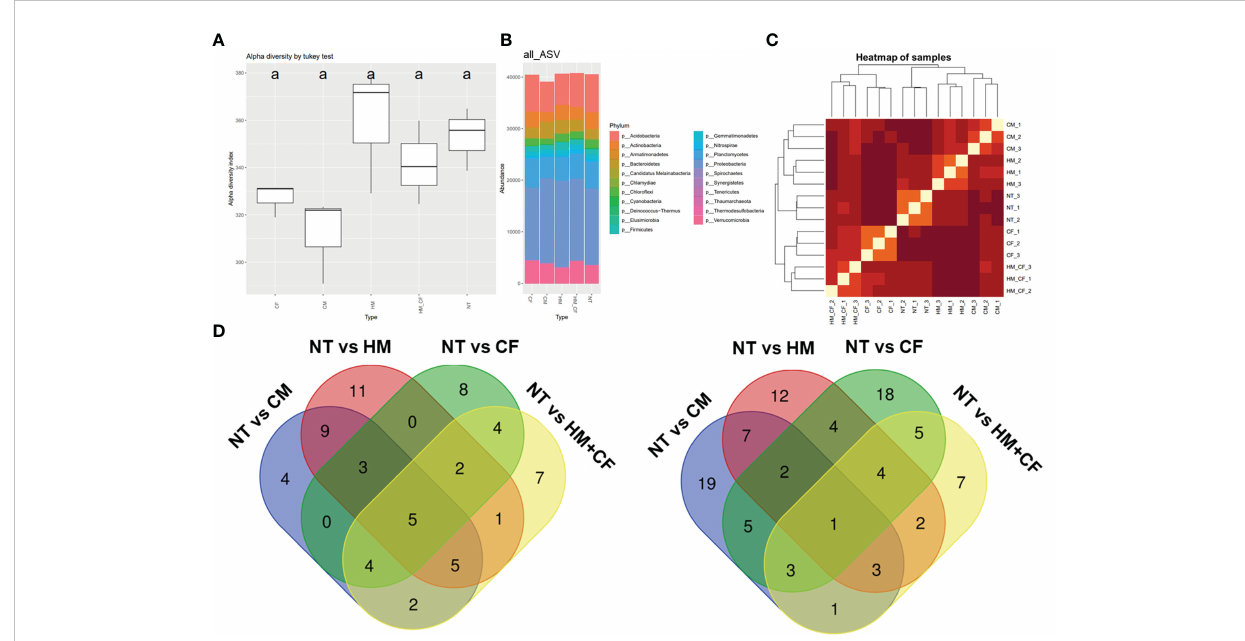
FIGURE 4 Amplicon sequence variant (ASV) approach of bacteria in the soils after different fertilizer supplies (NT, non-treatment; CM, commercial manure; HM, Hanwoo manure; CF, chemical fertilizer; HM+CF, combined use of Hanwoo manure and chemical fertilizer). (A) Alpha diversity of the bacterial population in each sample using the inverse Simpson (InvSimpson) method. The lowercase letters represent the signi fi cant differences (p < 0.05) between groups by using Tukey ’ s HSD test. (B) Bacterial communities of each sample in the phylum level. The box colors represent the phylum of bacteria. (C) Hierarchical clustering of samples. The line colors represent the different levels of beta diversity using the Bray − Curtis dissimilarity. (D) The comparison of differentially distributed bacteria in the soils after different fertilizer supplies.